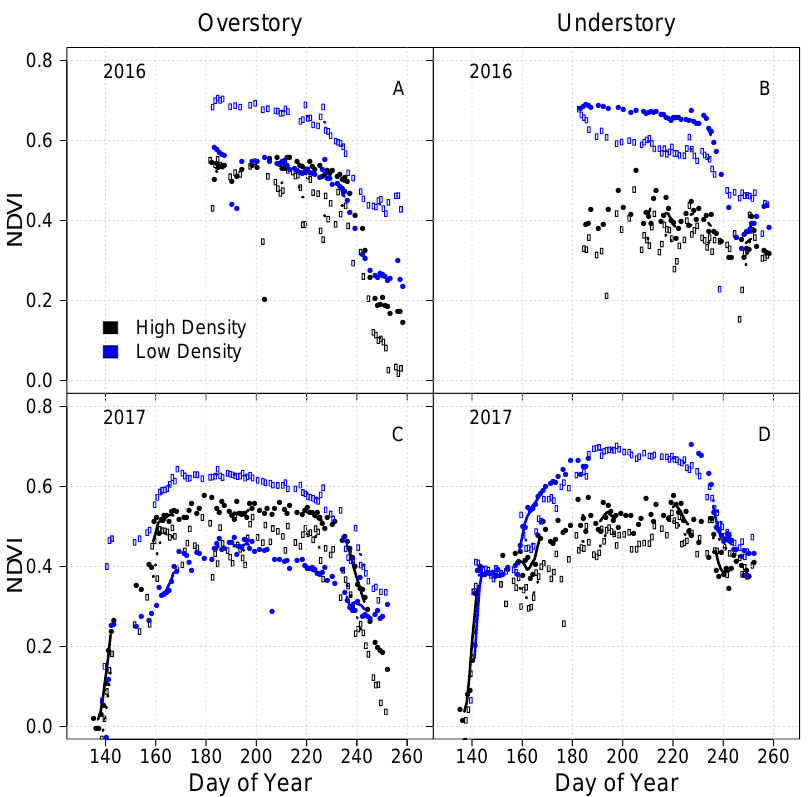
Figure 7. Field observations of NDVI from overstory ( A ) and understory ( B ) sensors for 2016, and from overstory ( C ) and understory ( D ) sensors in 2017. Blue and black symbols represent measurements from the low- and high-density stands, respectively. Open and closed circles indicate replicate (east- and west-facing) sensors at each stand. Points represent daily observations and lines are a 5-day running mean.